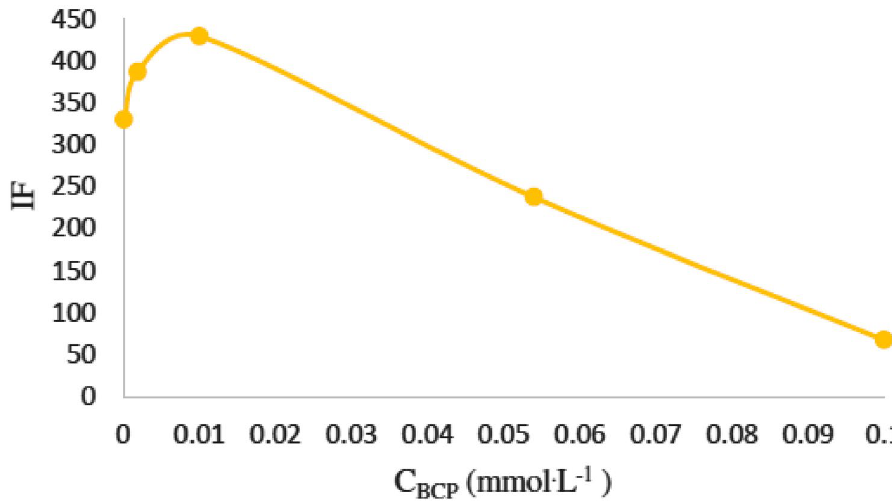
Fig. 3 Effect of BCP concentra- tion on the relative IF of the reaction system